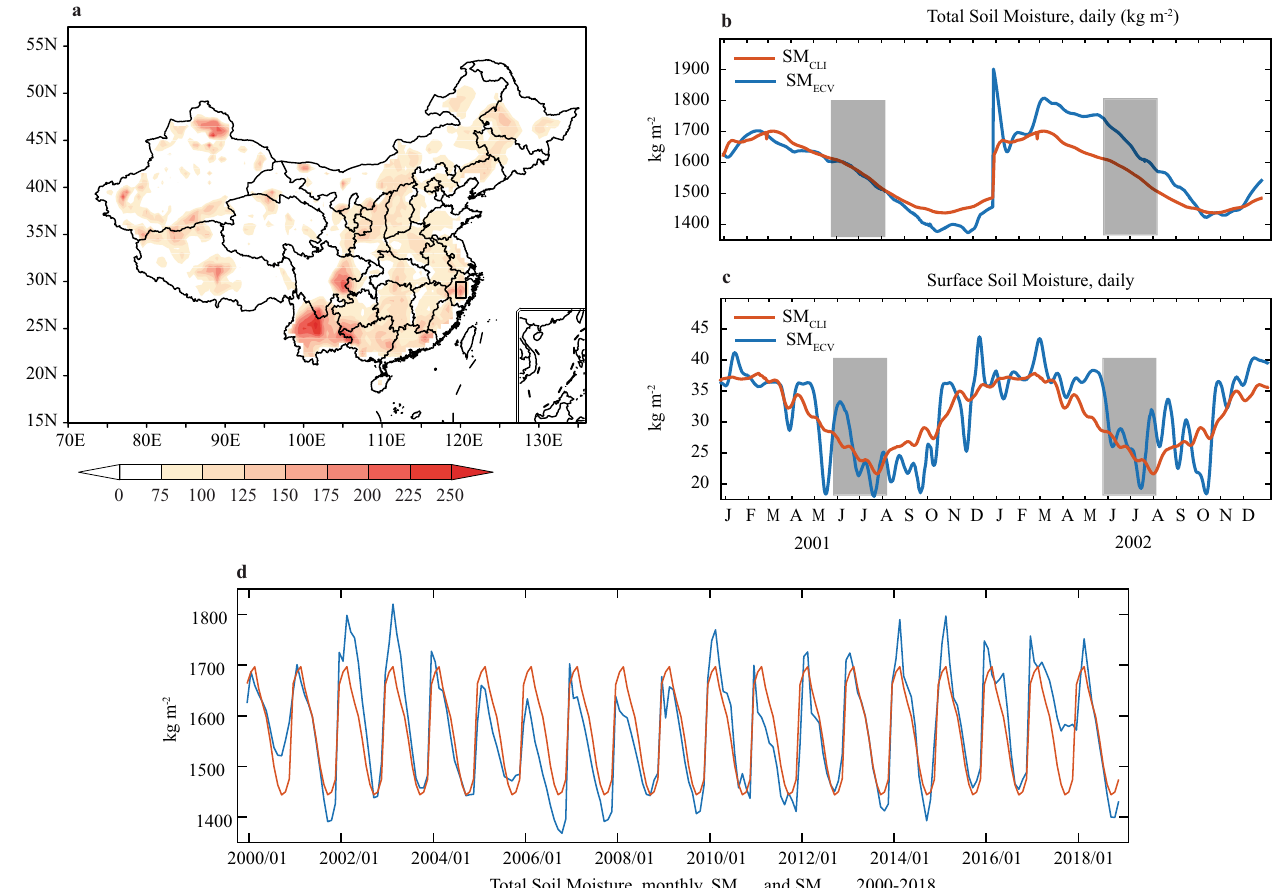
Fig. 4 The spatiotemporal variability and deviation of SM between the SM ECV and SM CLIM simulations. The difference in the a Standard deviation of daily total-column SM between SM ECV and SM CLIM (unit: kg m -2 ) over 2000 – 2018. b Monthly evolution of the area average [118° – 121°E: 28° – 30°N] SM from 2001 to 2002. c Daily total surface SM values over two seasonal cycles (2001 – 2002) and d monthly total difference between the SM ECV and SM CLM results in drier conditions over Northeast China and wetter conditions over South-east China, implying underestimations over the Northeast China and overestimations over the Yangtze River basin and southeastern China. Such biases are previously reported over the study region due to the model and boundary layer uncertainties, including the topographic effects 7,40 .